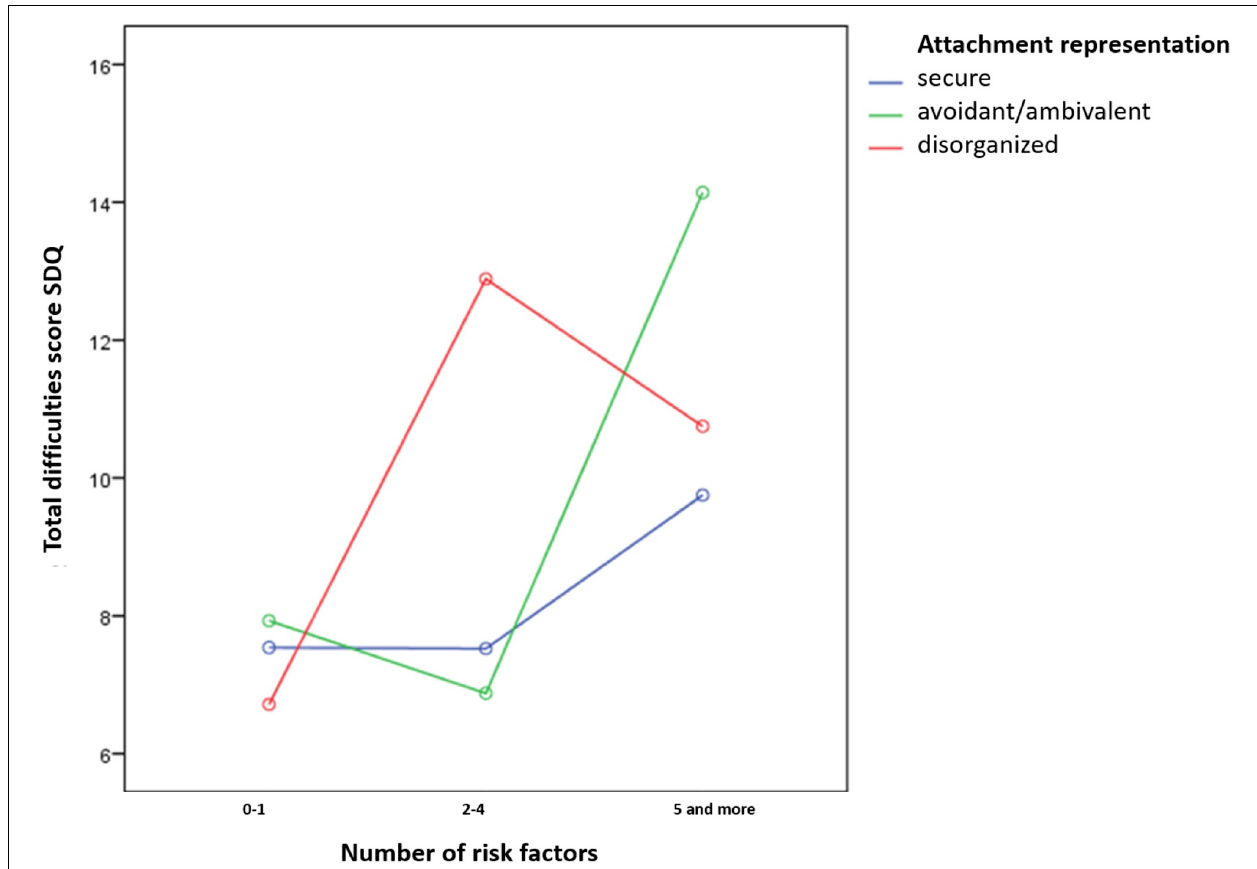
FIGURE 6 | Attachment representations in relation to number of factors and total difficulties score–SDQ.